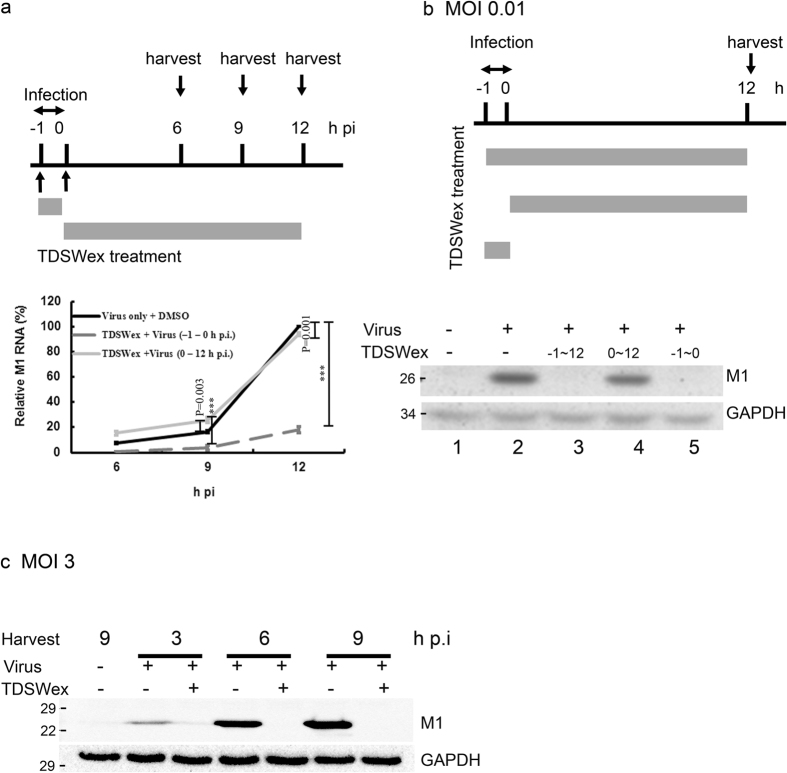
TDSWex treatment in the postadsorption stage could not inhibit viral RNA synthesis and protein production.(a) A schematic design of the TDSWex treatment. MDCK cells were infected with WSN at an MOI = 0.01. During or after adsorption, the infected cells were treated with TDSWex (0.1 mg/mL) or DMSO (0.05%), and then harvested at the indicated time p.i. Viral RNA levels were represented by M1 which were normalized by GAPDH through RT-qPCR, and were calculated from three independent experiments. (b) A scheme of TDSWex treatment for examining viral protein synthesis. Viral protein expression was represented by M1, with GAPDH as a loading control. This is a representative result of three independent and reproducible experiments. (c) Time-of-addition and western blot experiments with an MOI of 3, and collected samples from one single replication cycle. TDSWex was added to the infected cells at –1 h p.i.